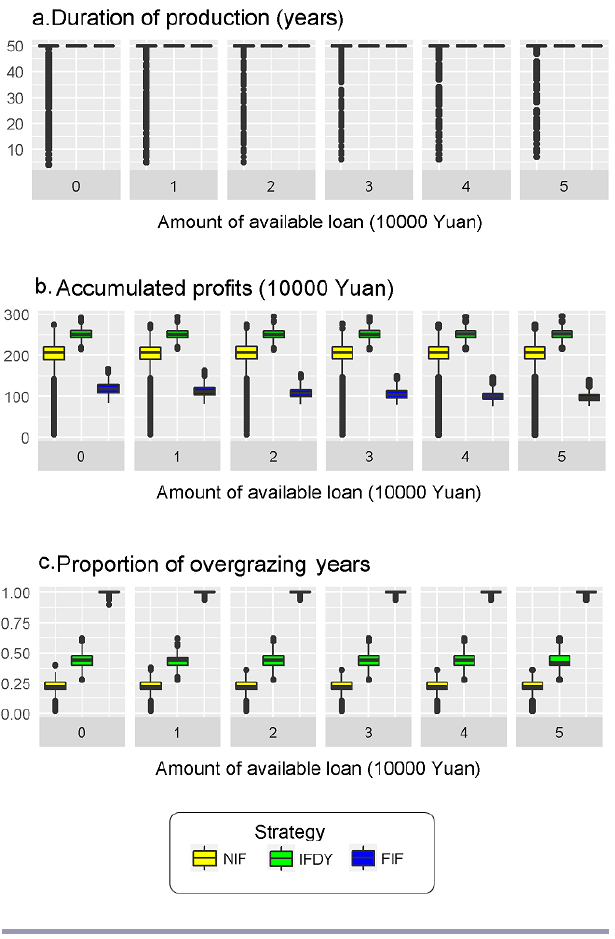
Fig. 8 . Impacts of loans on (a) household livelihood, (b) livestock production, and (c) ecosystem health with different forage import strategies when the price of livestock was twice that of baseline scenario. NIF - no import of fodder, IFDY - import of fodder only in disaster years, FIF - frequent import of